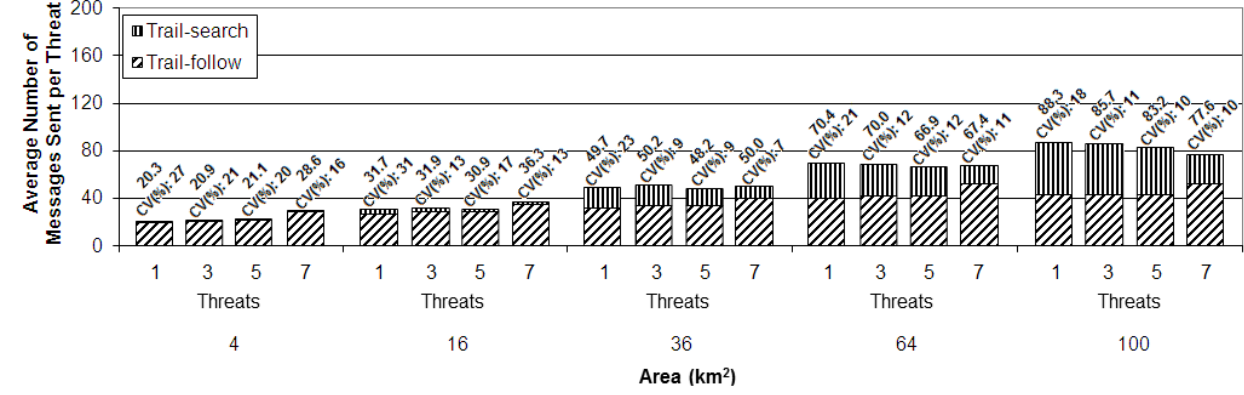
Figure 13. Results of the cost metric in terms of the average number of messages sent per threat for the simulations with 4 Unmanned Aerial Vehicles and the four different numbers of threats (1, 3, 5 and